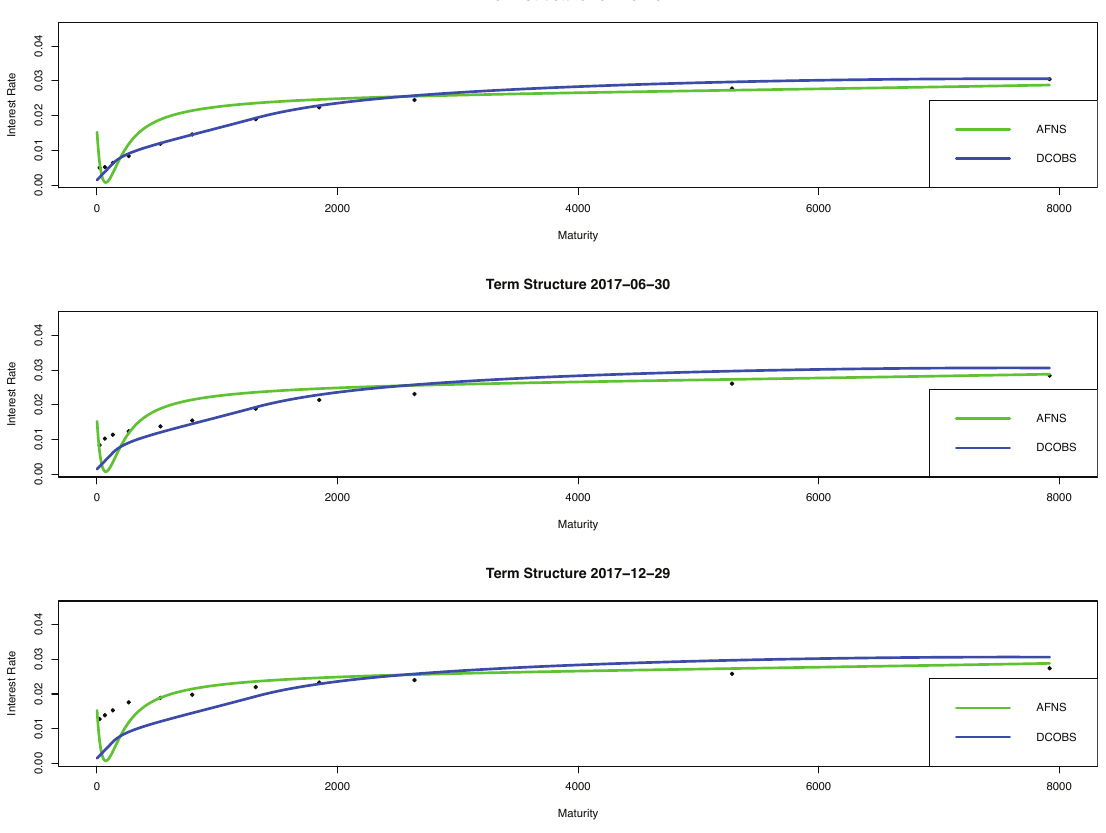
Figure 4. Short-, medium- and long-term forecasts for AFNS and DCOBS